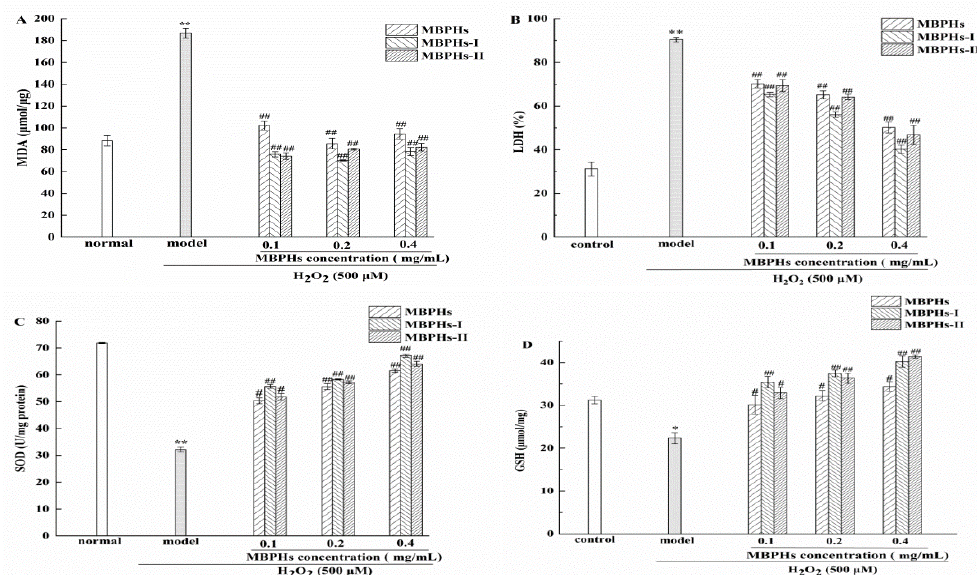
Figure 4. Protective effects of MBPHs, MBPHs-I, and MBPHs-II from mung bean on the H 2 O 2 -induced NCTC-1469 cells. ( A ) Effect on the malonaldehyde (MDA) level; ( B ) effect on the activity of lactate dehydrogenase (LDH); ( C ) effect on the activity of superoxide dismutase (SOD); ( D ) effect on the glutathione (GSH) content. Results shown are expressed as means ± SD ( n = 6), * p < 0.05, ** p < 0.01 vs. control group, # p < 0.05 vs. model group, ## p < 0.01 vs. model group.